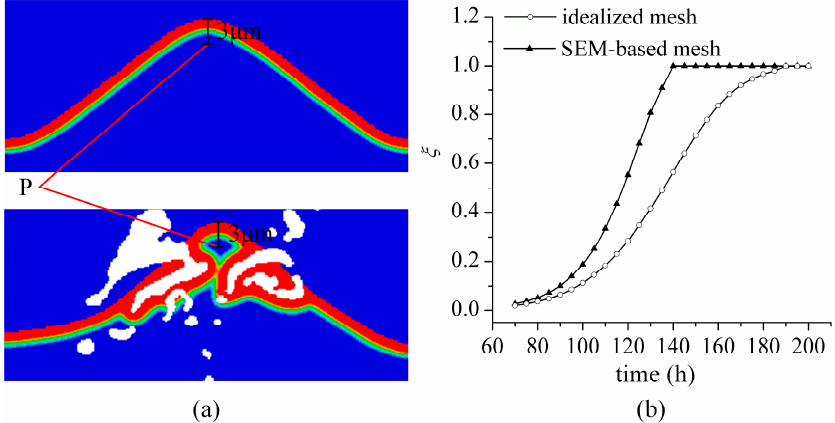
Figure 7. ( a ) The contour plot of TGO layer and the location of points P of both TBC samples and ( b ) the evolutions of molar friction of TGO at the points P.